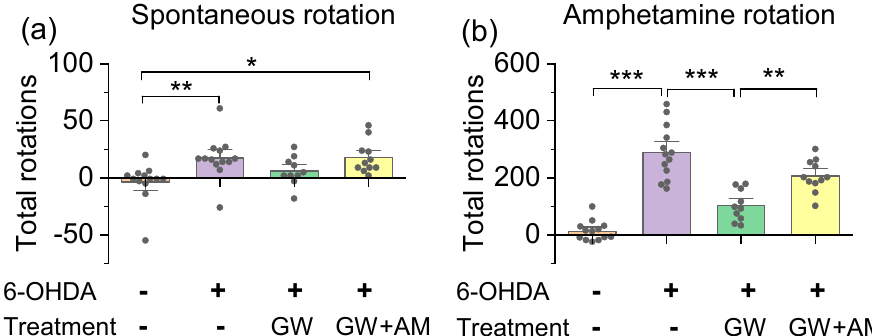
Figure 6. GW842166x (GW) treatment decreased spontaneous and amphetamine-induced rotations. ( a ) Mice unilaterally injected with 6-OHDA exhibited an increase in spontaneous rotations compared to vehicle-injected mice (** p = 0.009, n = 13–13). GW without AM630 (AM) co-treatment did not significantly alter the number of spontaneous rotations relative to control mice ( p = 0.484, n = 10–13). GW plus AM co-treatment significantly increased the number of spontaneous rotations relative to 6-OHDA controls (* p = 0.011, n = 11–13). ( b ) Unilateral 6-OHDA injection increased amphetamine- induced (5 mg/kg, i.p.) net rotations relative to control mice (*** p < 0.001, n = 13–13). This increase in rotations was attenuated by GW treatment (*** p < 0.001, n = 10–13), and the effect of GW was prevented by AM co-treatment (*** p = 0.004, n =